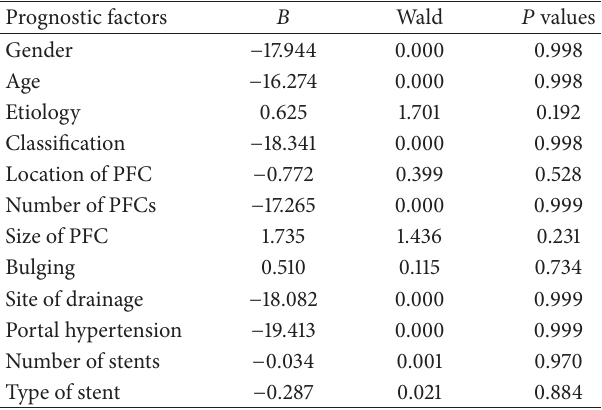
Table 3: Prognostic factors logistic regression for successful endo- scopic ultrasound-guided drainage of PFCs (follow-up: 48